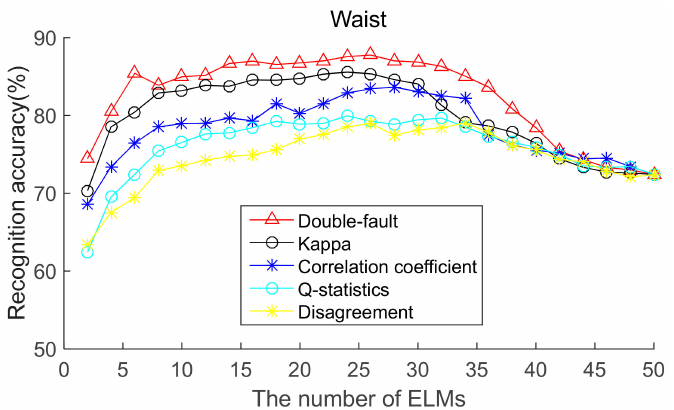
Figure 6. Recognition accuracy from waist position for ordered bagging according to five pairwise diversity measures.